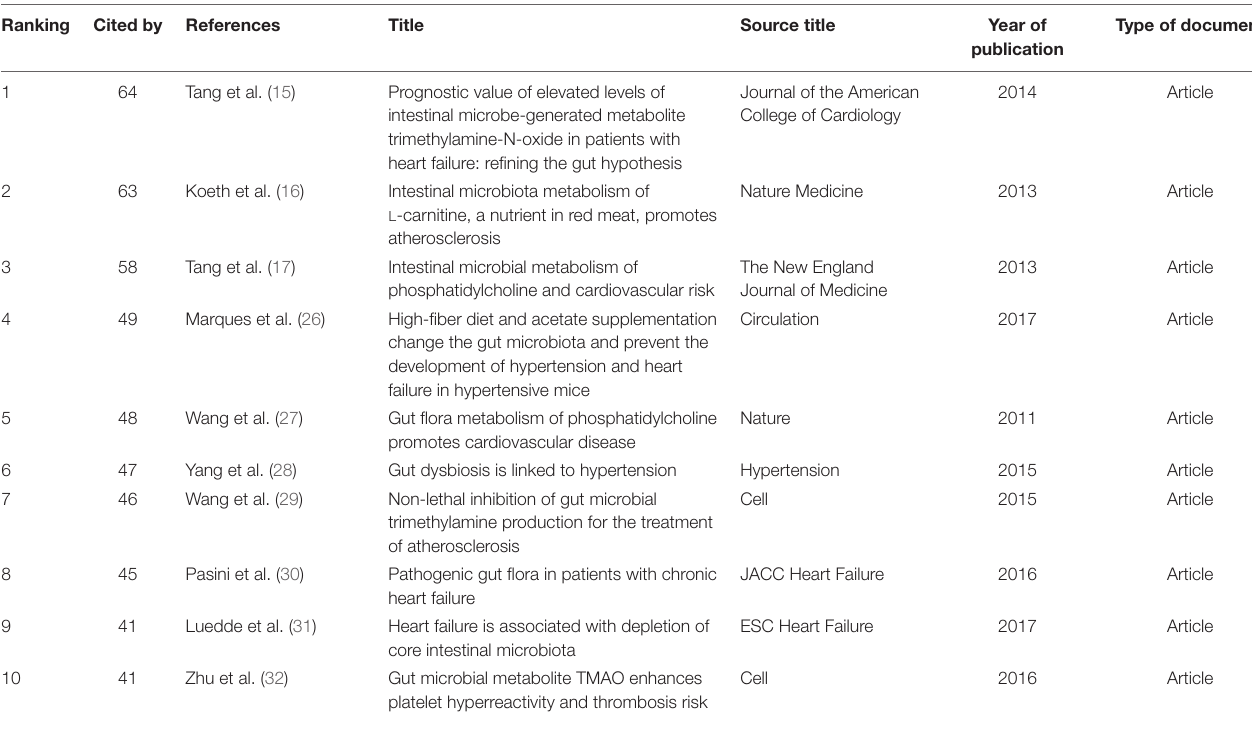
TABLE 5 | Ranking of the top 10 co-cited references for gut microbiota research in the heart failure